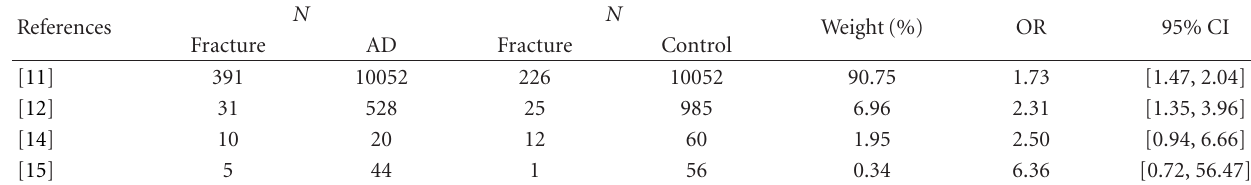
Table 2: Summary of the studies of the association between AD and hip fracture (dichotomous data).